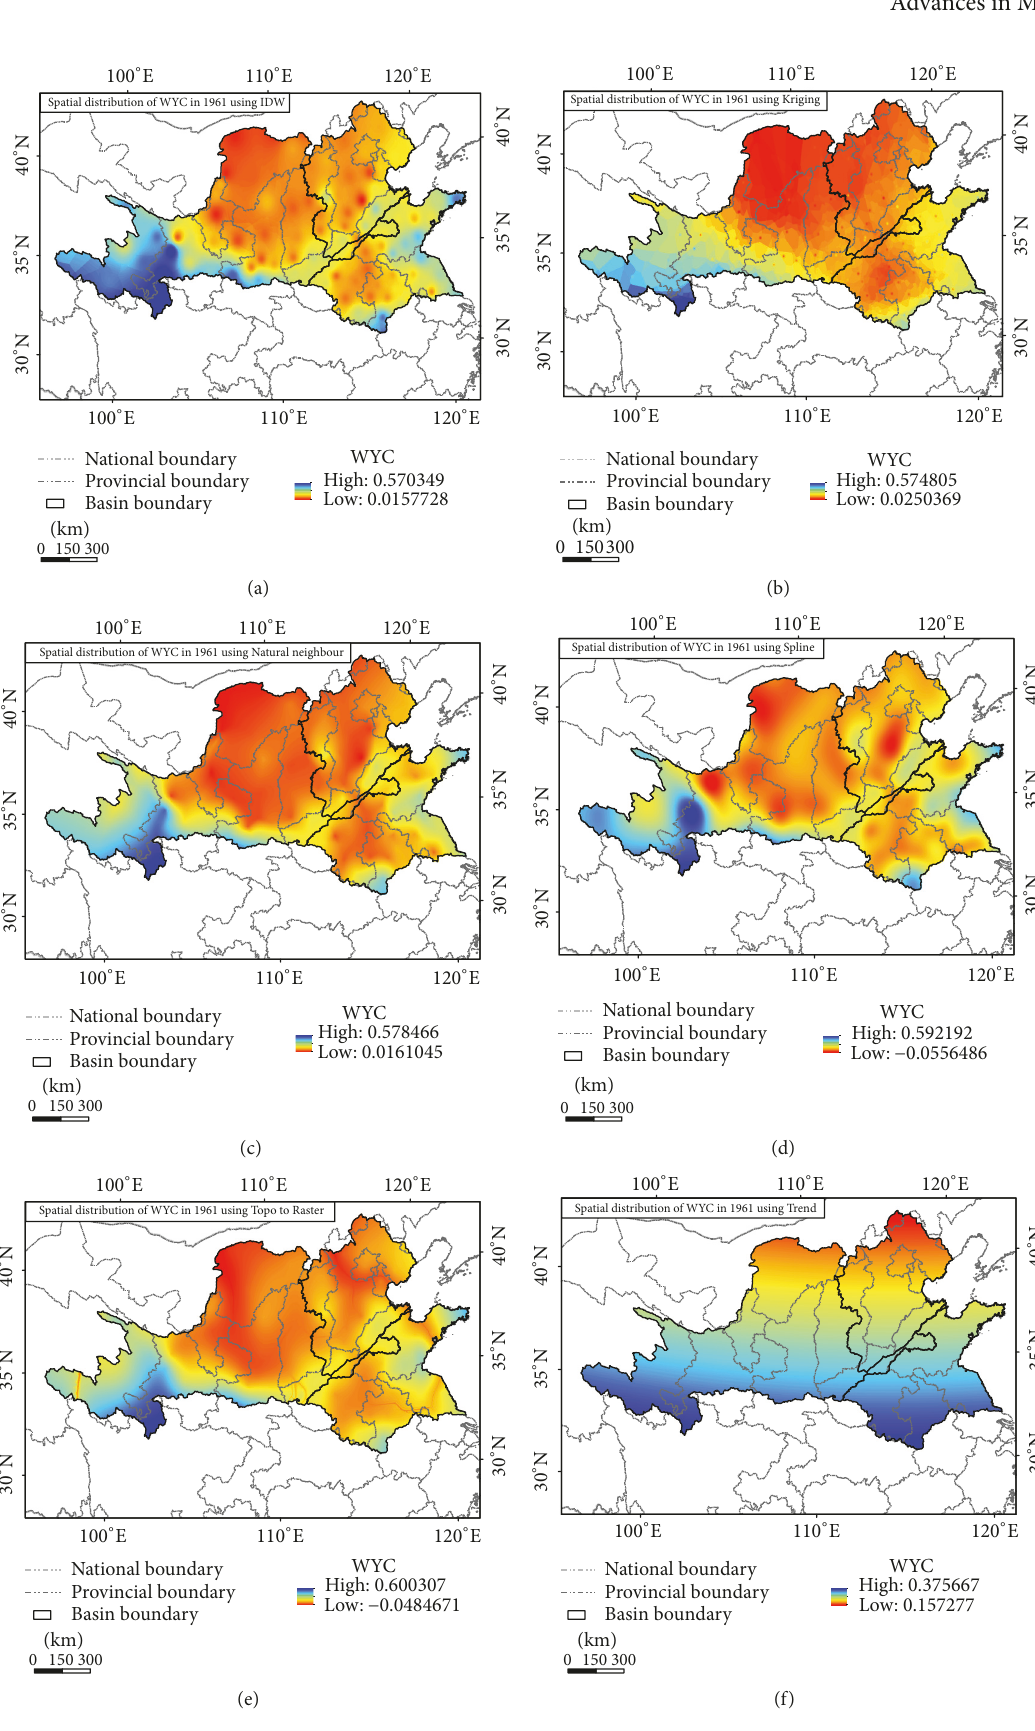
Figure 27: Interpolation results for six different